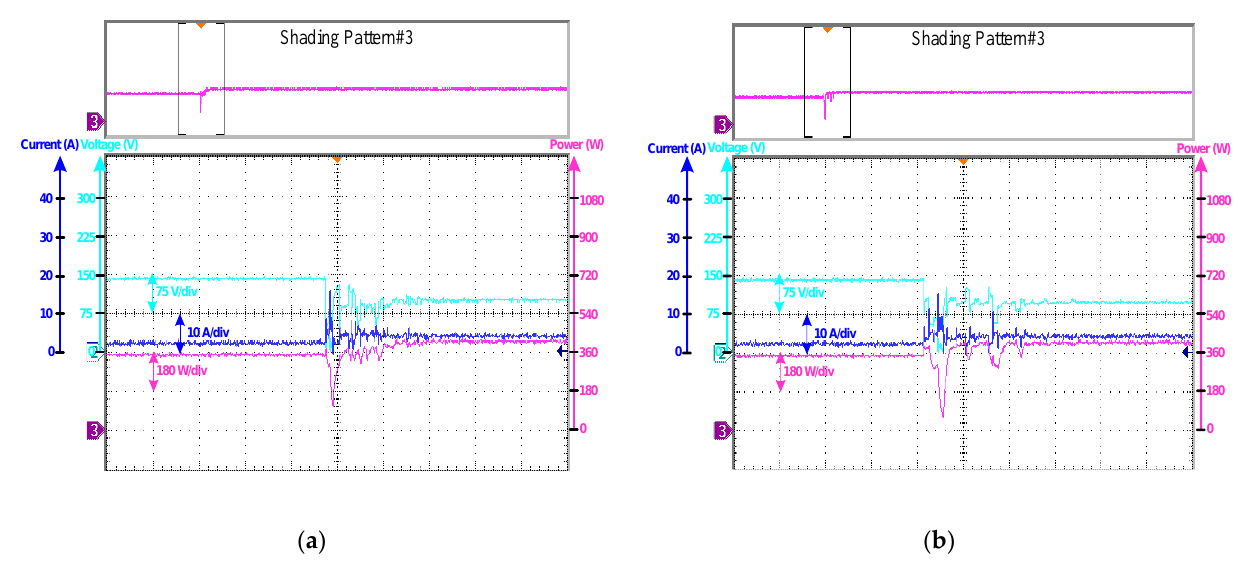
Figure 12. Experimental results of output power and voltage of the SP#3 using: ( a ) CSO; ( b ) PSO. Figure 13. Experimental results of output power and voltage of the SP#4 using: ( a ) CSO; ( b )